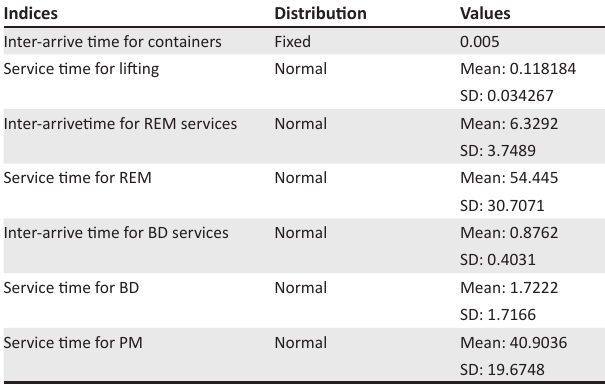
TABLE 5: Values and distributions for main indices in simulation